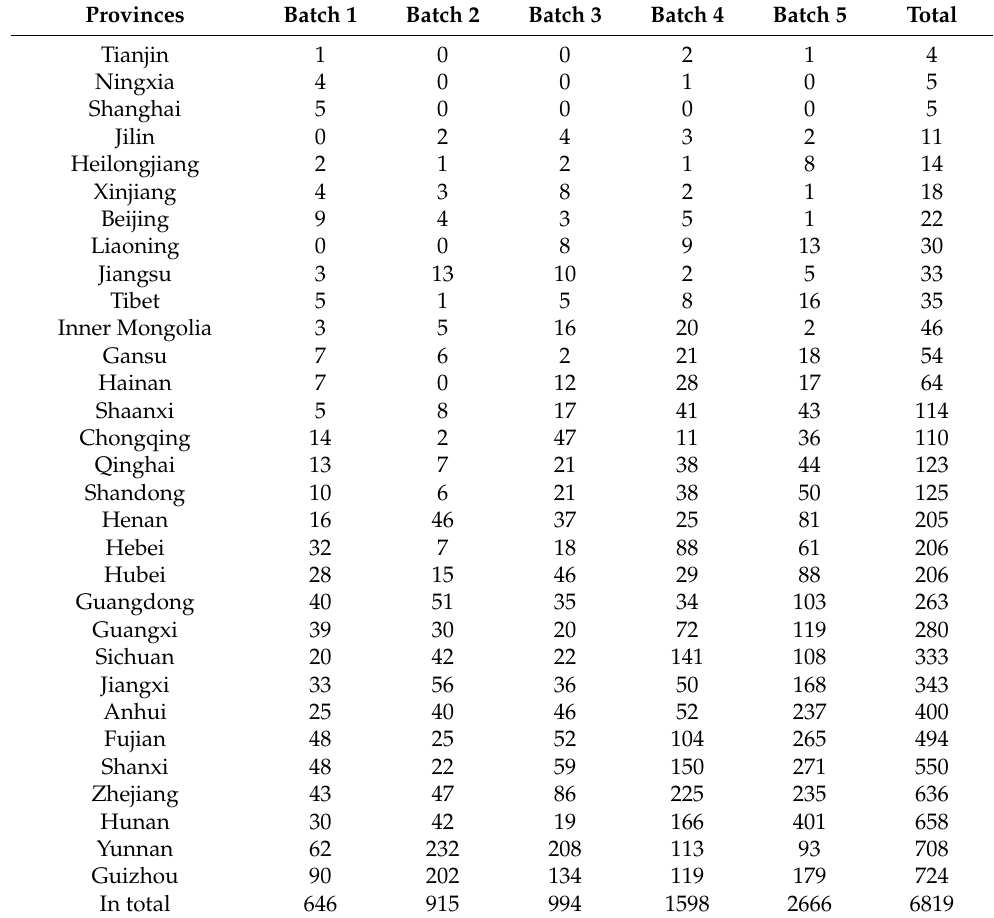
Table 1. Number of traditional villages announced in different batches in China. Provinces Batch